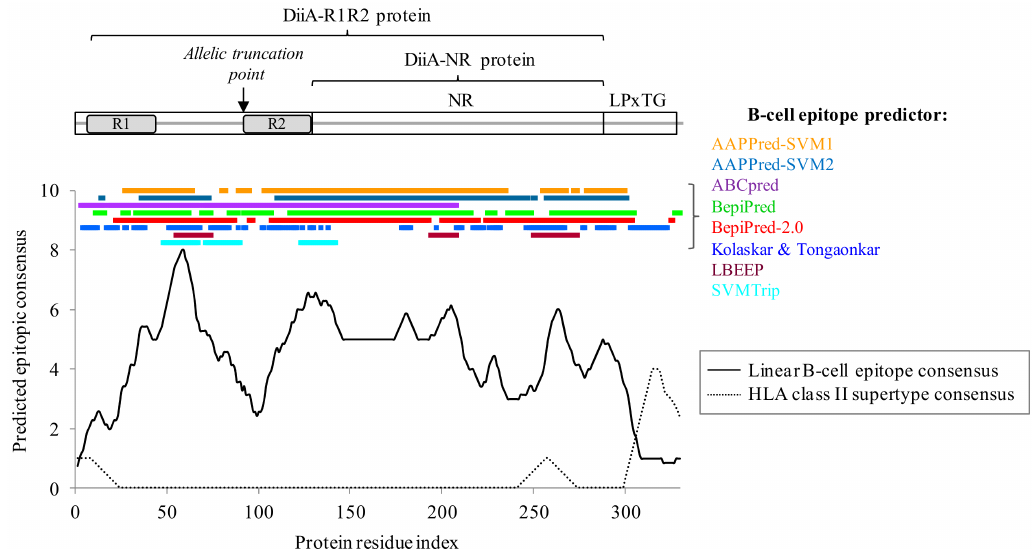
Figure 1. DiiA domain organization and B-cell/HLA class II epitope prediction. The predicted epitope consensus is the resultant of applying a window of seven residues for B-cell epitopes and 15 residues for HLA class II epitopes, their respective average